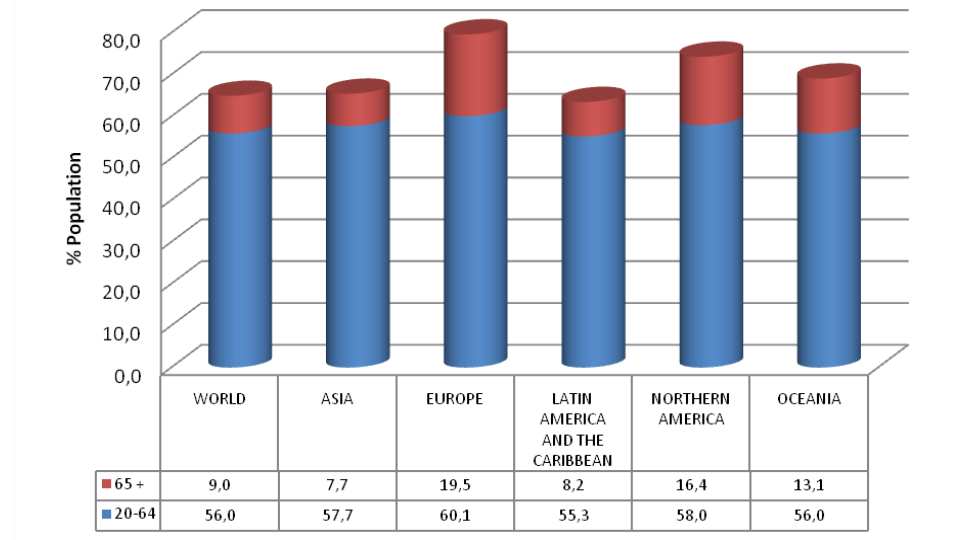
Figure 2. United Nations, Department of Economic and Social Affairs, Population Division (2011). World Population